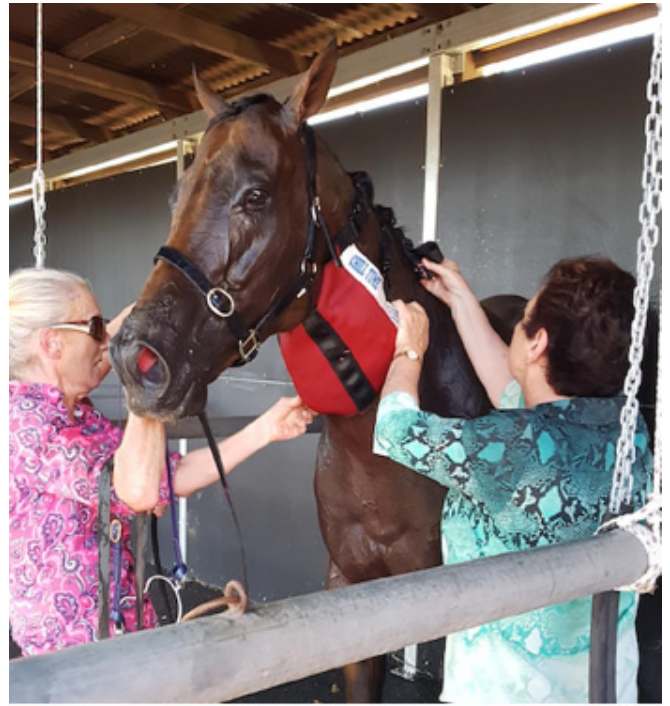
Figure 13. The author (MB, right) applying a cooling collar to a horse in the immediate post-race period. The horse showed signs of distress, irritability, restlessness, and was occasionally kicking out. It has been cooled with iced water and the ice collar used as an adjunct to whole body cooling. Note the dull-eyed look, slack ear position, and the dilated nostrils. Source—J Equine Vet Ed,